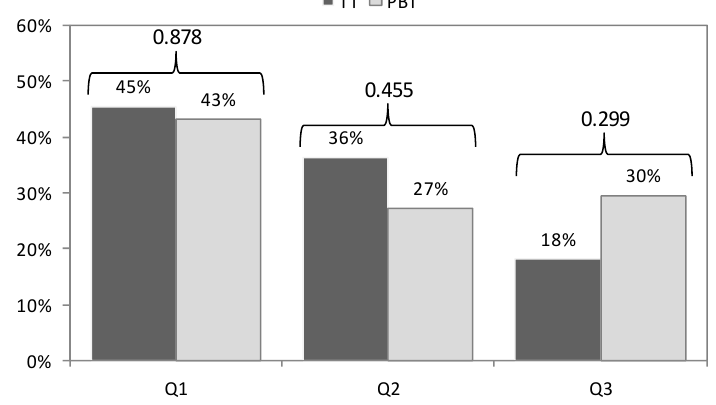
Figure 3. The ranks of journals where thesis-related articles listed in Web of Science and published in journals with Impact Factor (TT = Traditional theses; PBT = Publication-based theses).